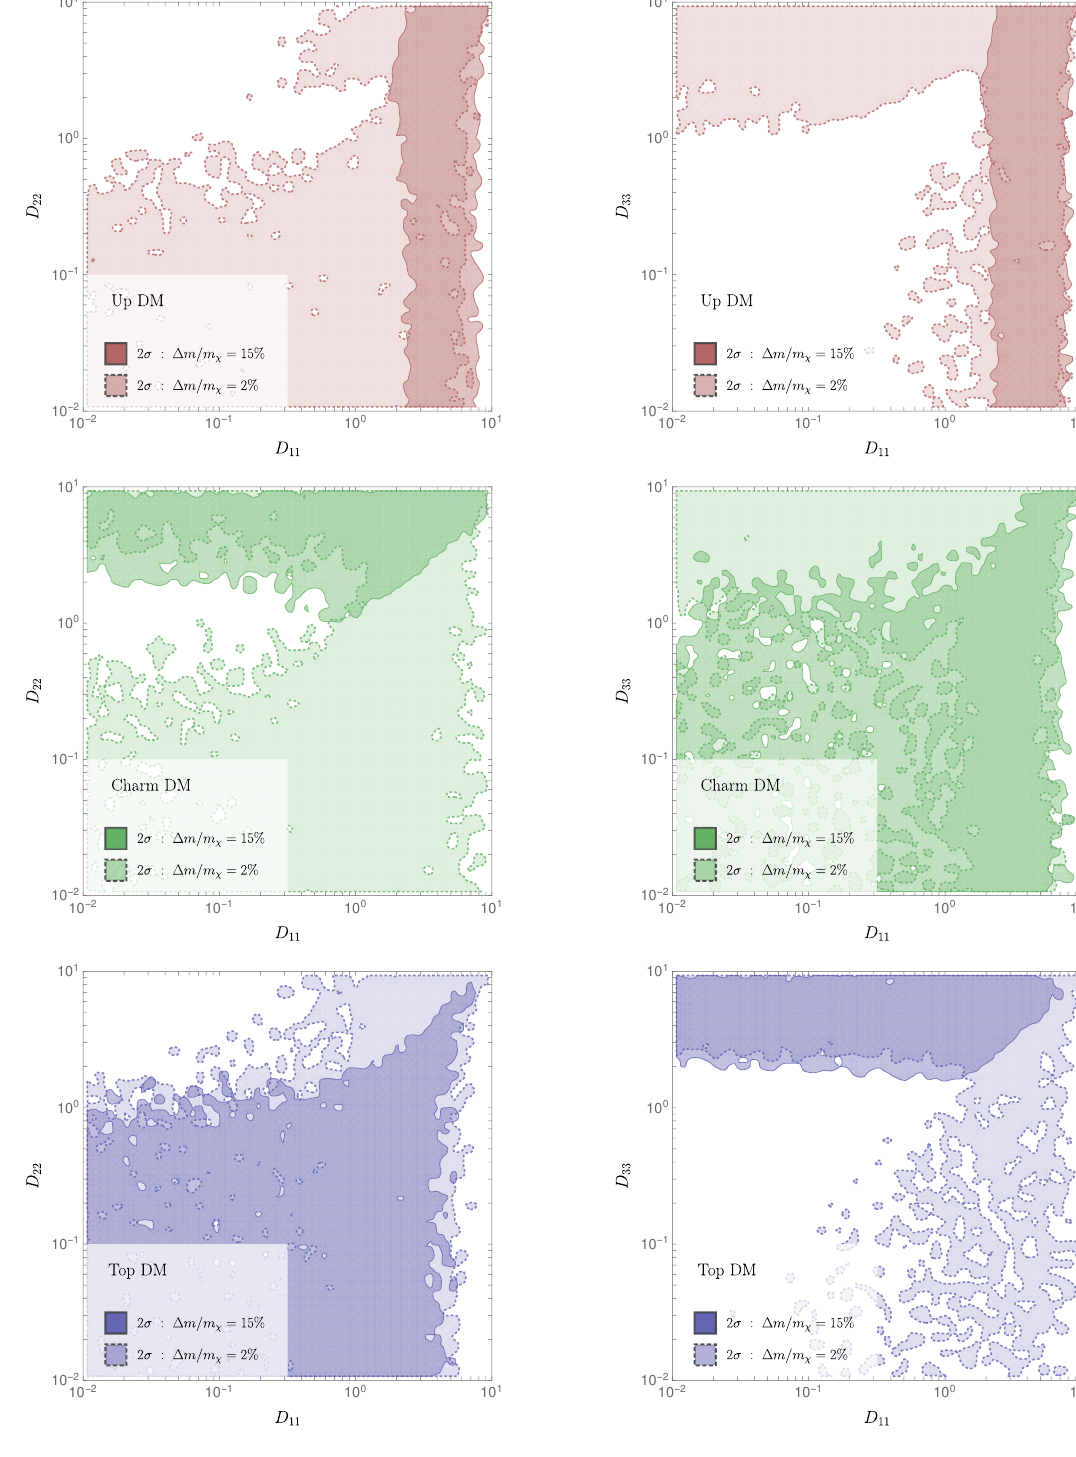
Figure 15 . As for (cid:12)gure 14 but for the D of mass splitting (dashed shaded, and solid darker shaded respectively).